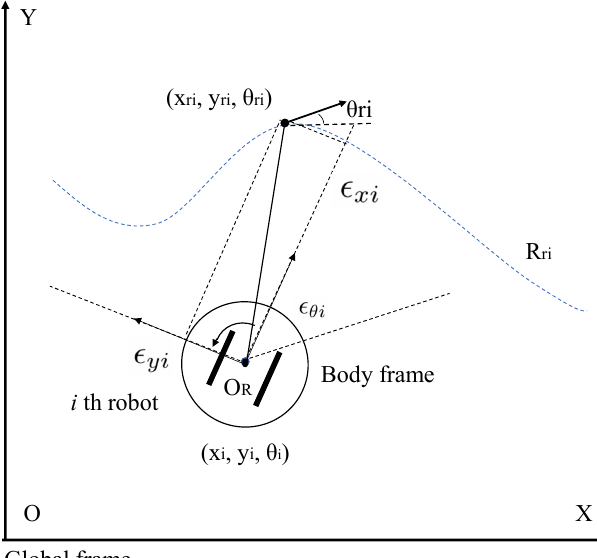
Figure 5. The i th robot and interpretation of tracking